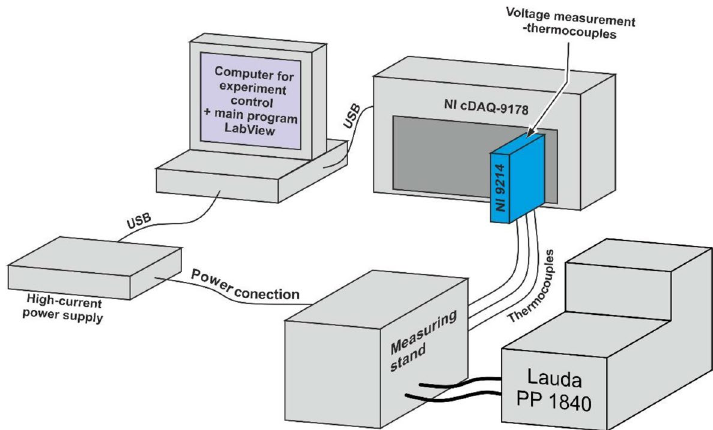
Figure 6. Scheme of the measuring system.